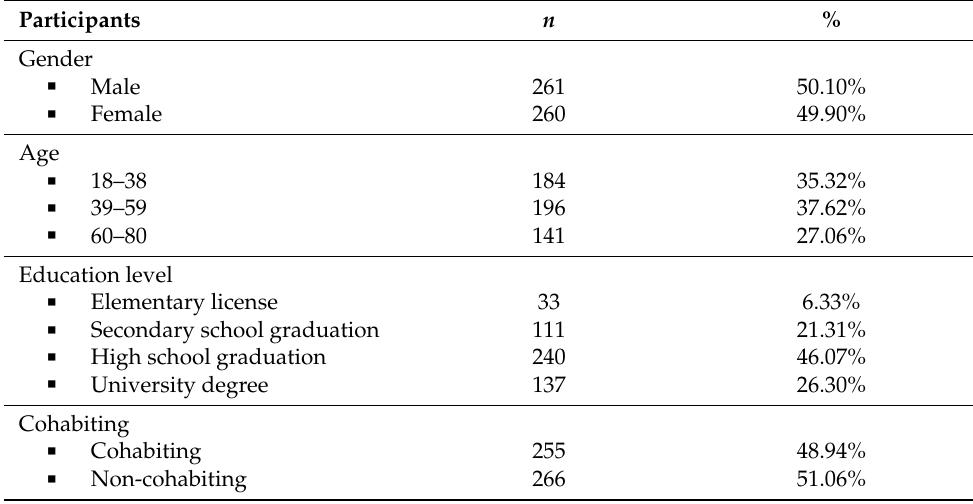
Table 2. Socio-demographic characteristics of the studied population.